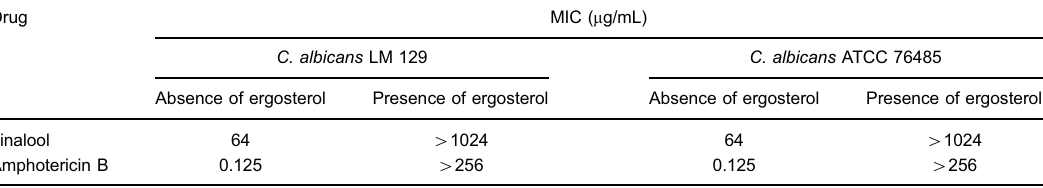
Table 3. Effect of linalool and amphotericin B against C. albicans LM 129 and C. albicans ATCC 76485 in the absence and presence of ergosterol at 400 m g/mL.